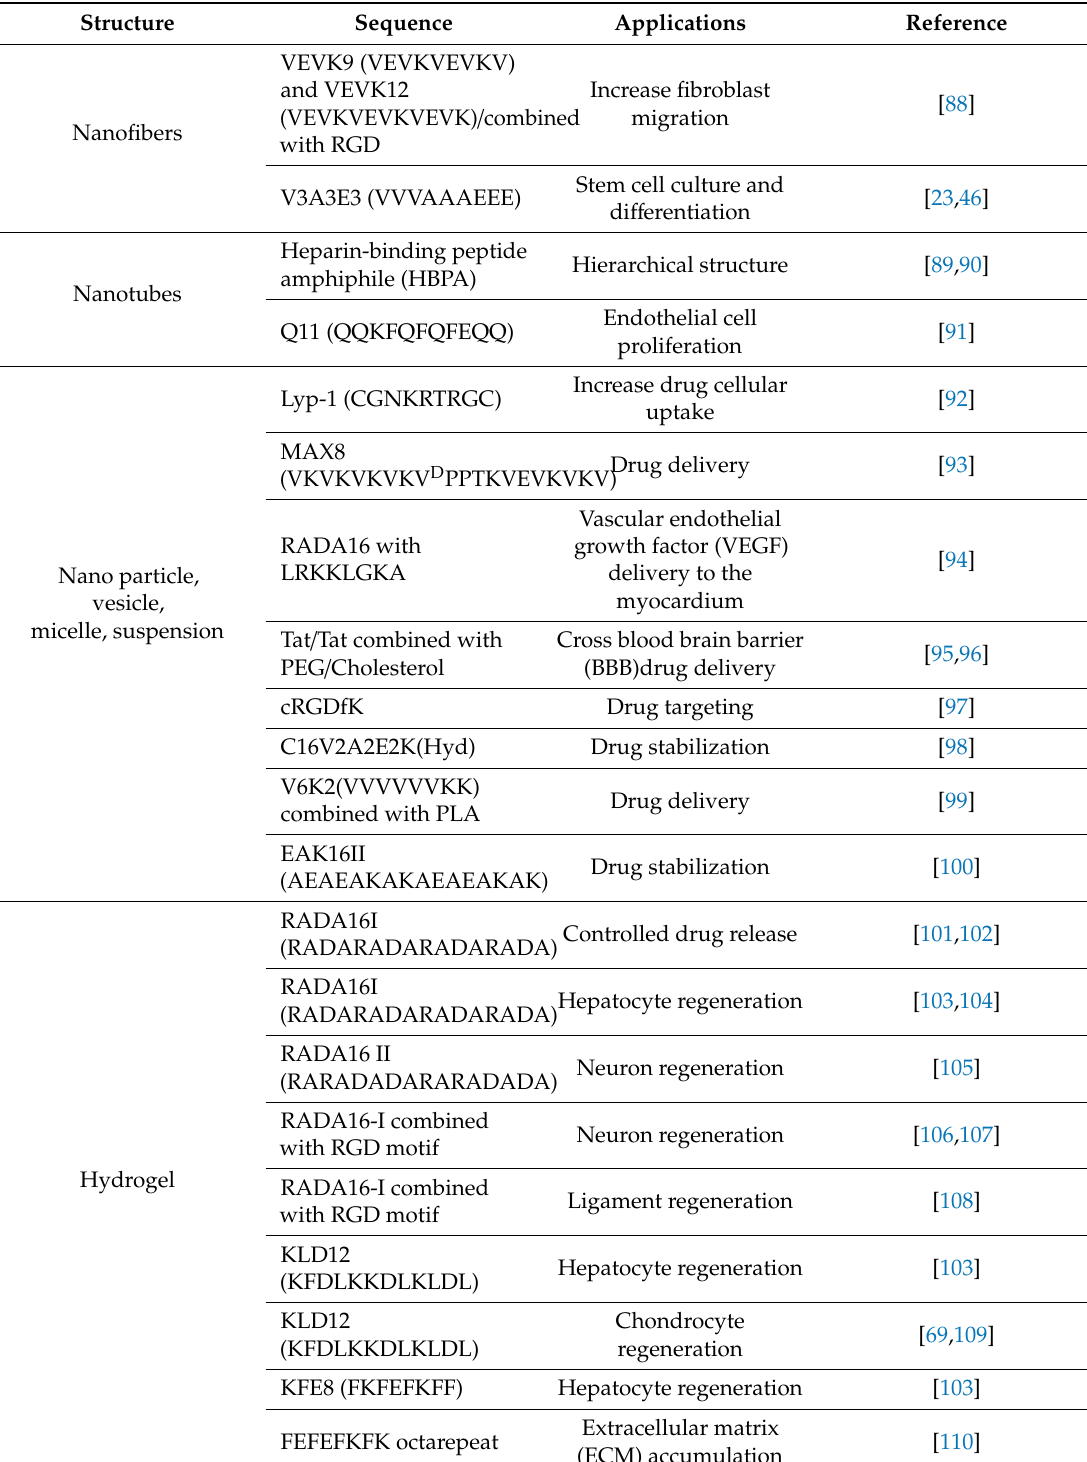
Table 2. List of self-assembling peptide sequences and resultant nanostructures used for disease